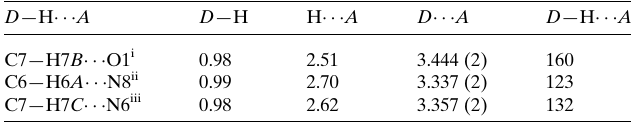
Table 2 Hydrogen-bond geometry (A˚ , (cid:2) ) for 2 .